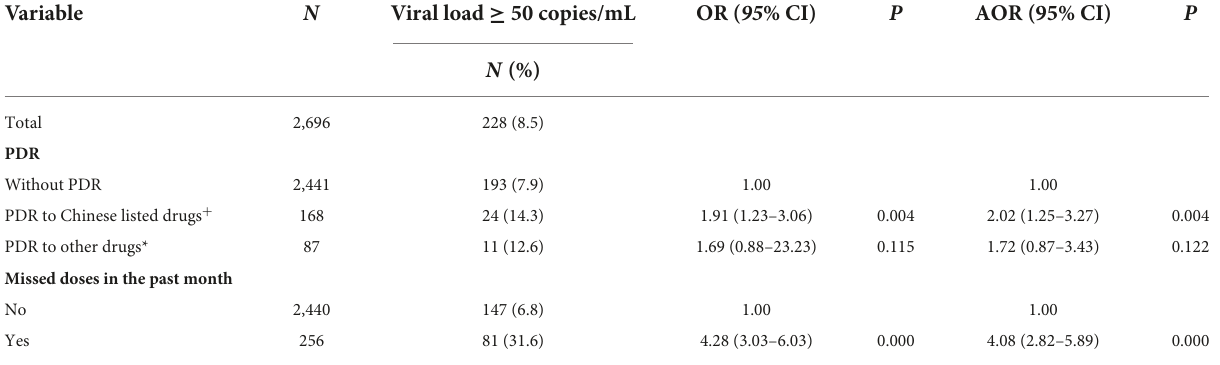
FIGURE4 Flow chart.